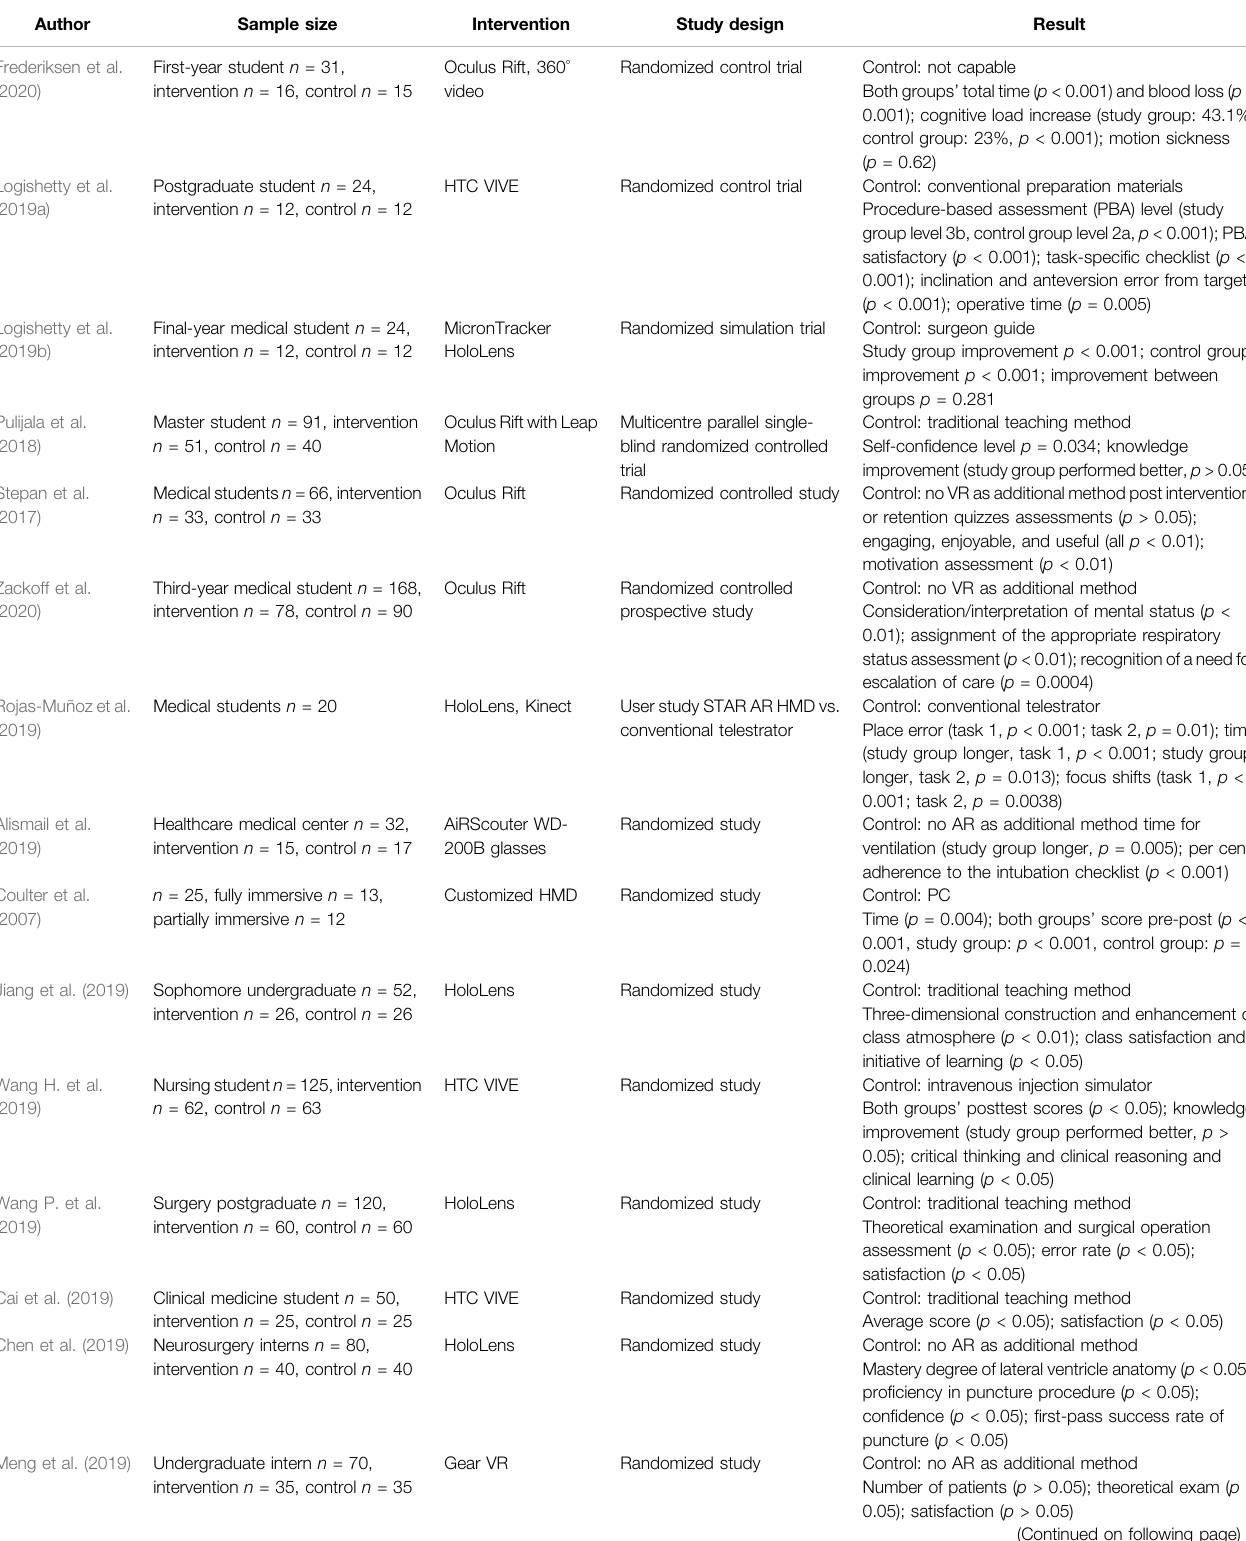
TABLE 1 | General data of 17 included